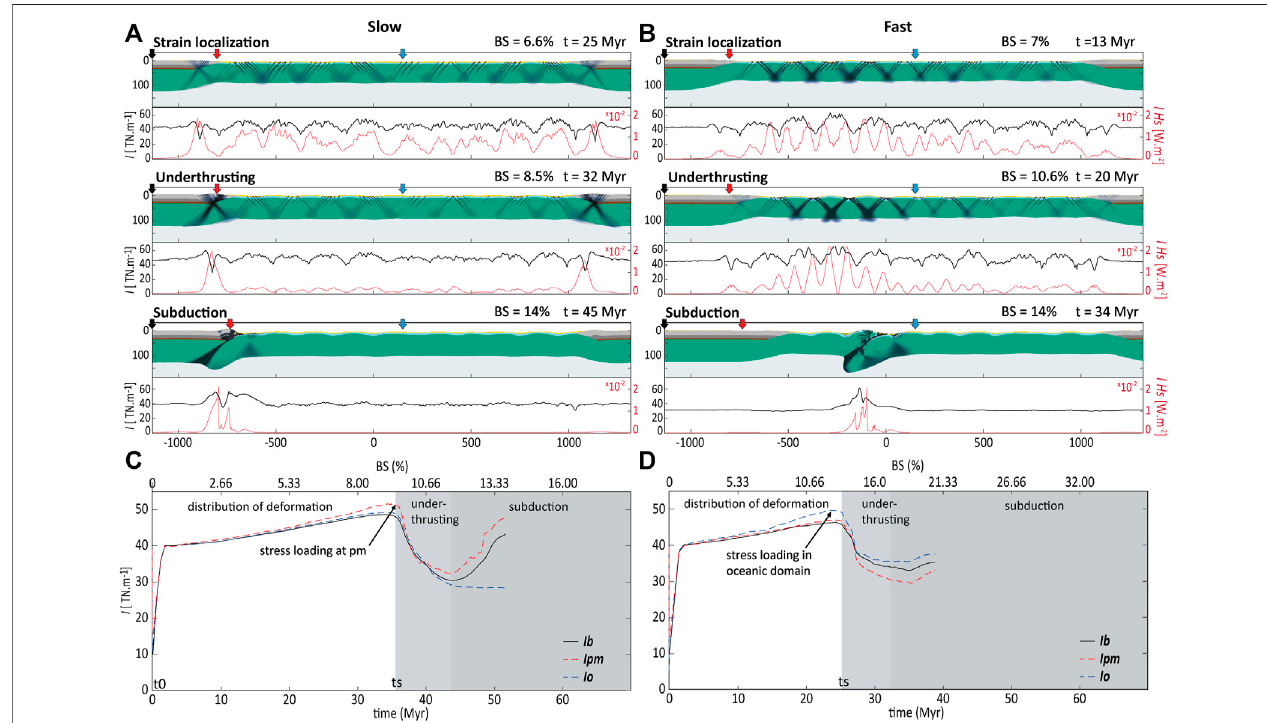
FIGURE5| Effectofconvergencerateonmodeofsubductioninitiationinmodelseries2.Inversionofa30Myroldoceanicbasinatconvergencerateof0.8 cmyr -1 (left) and1.6cmyr -1 (right) . (A,B) Modelevolution,displayedintermsofcompositionofthelithosphereoverlainbythesecondinvariantofthestrainratetensortoshow strain localization mechanism (top panel) , and integrated stress I (black curve) and integrated heat production by visco-plastic dissipation IHs (red curve) over the thickness of the lithosphere (bottom panels) . (C, D) Evolution integrated stress for three locations indicated by the coloured arrows (model boundary Ib , passive margin Ipm , oceanic basin Io ). Note that Io is an averaged value of integrated stress over the oceanic domain. BS is bulk shortening.